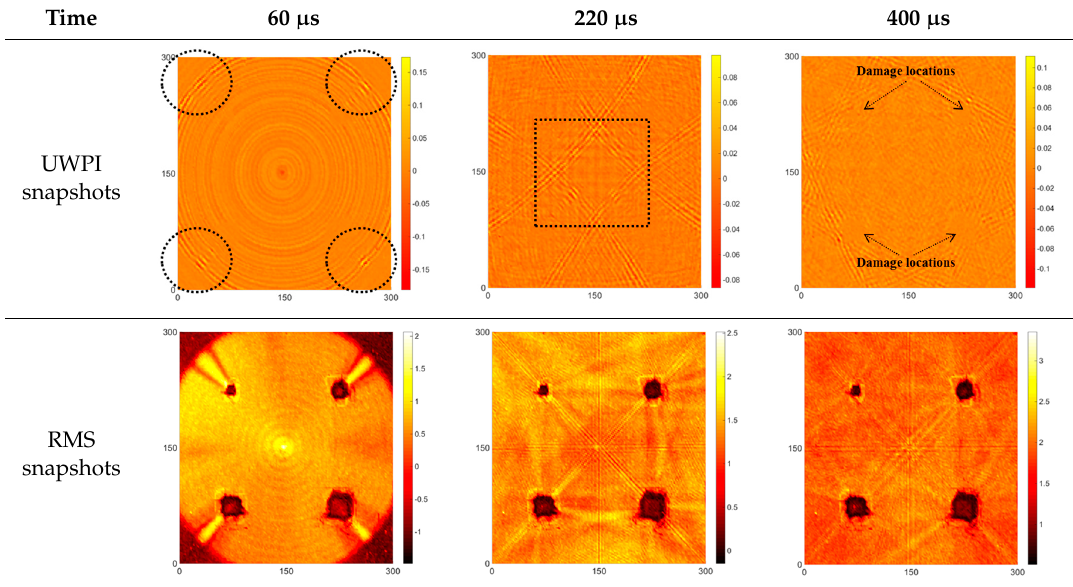
Table 8. UWPI and RMS snapshots of the front side of Specimen 2 at 60 μ s, 220 μ s and 400 μ s (the unit of x and y axis: mm).